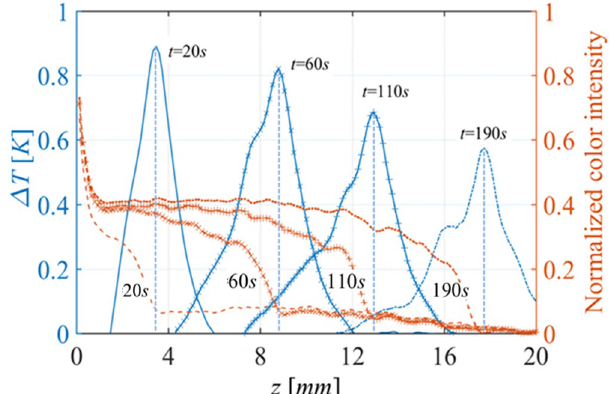
Figure 17. Profiles of saturation and temperature along a sample of RL 200 paper at different times (The measured positions were in respect to the lower edge of Plexiglas plate). Vertical dashed lines indicate the positions of temperature and wetting fronts.